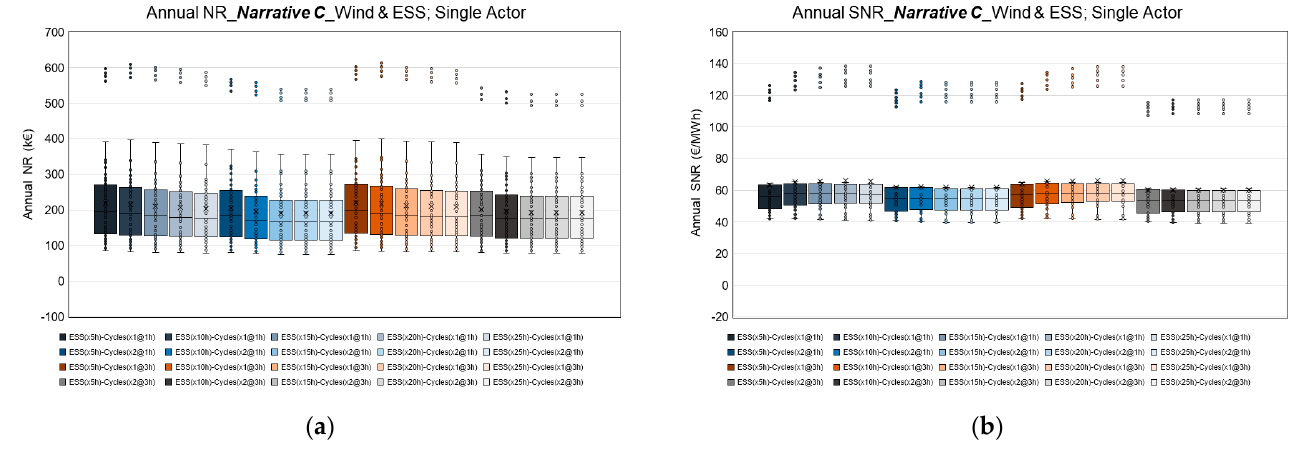
Figure 9. Wind-supported ESS and direct (excess) wind market participation for an individual wind-storage actor; annual NR ( a ) and SNR ( b ) per di ff erent storage con fi guration and cycling option.